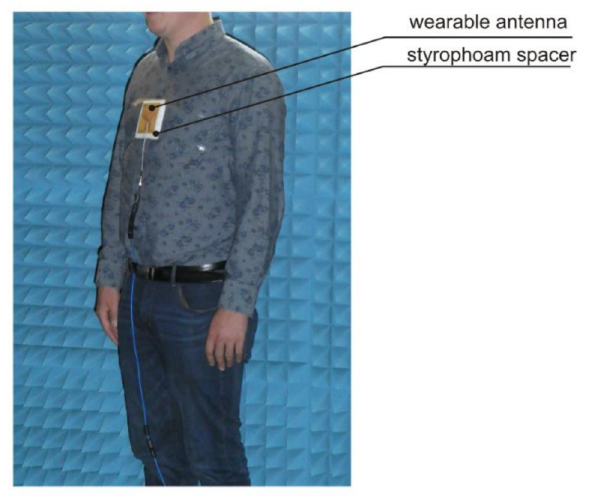
Figure 18. The prototype antenna attached to human subject for measurements.